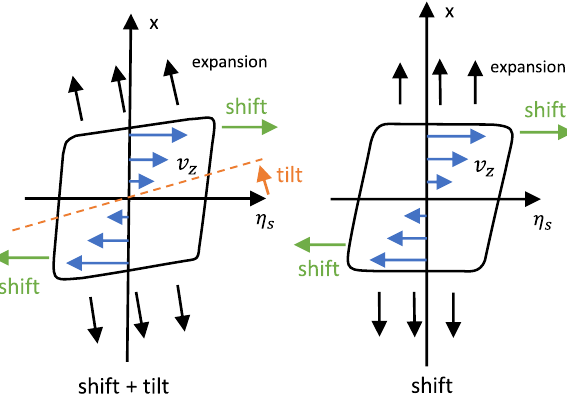
Fig. 6 Illustration of the initial energy density distribution on the x - η s plane, left for our Case (A) and Case (B) that include a counter- clockwisetilt,andrightforourCase(C)thatonlyincludesalongitudinal